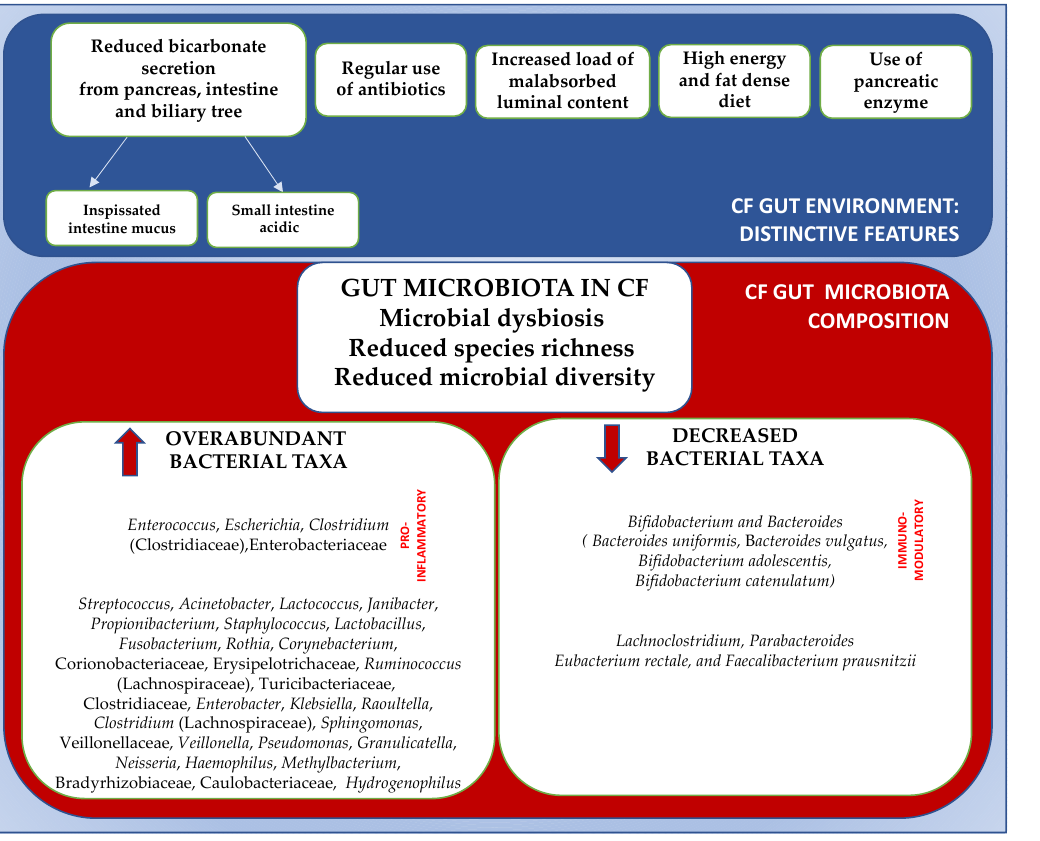
Figure 1. Gut distinctive features and gut microbial imbalance in CF patients. ↑ , increased; ↓ , decreased. Adapted from references [12,13,20,36].